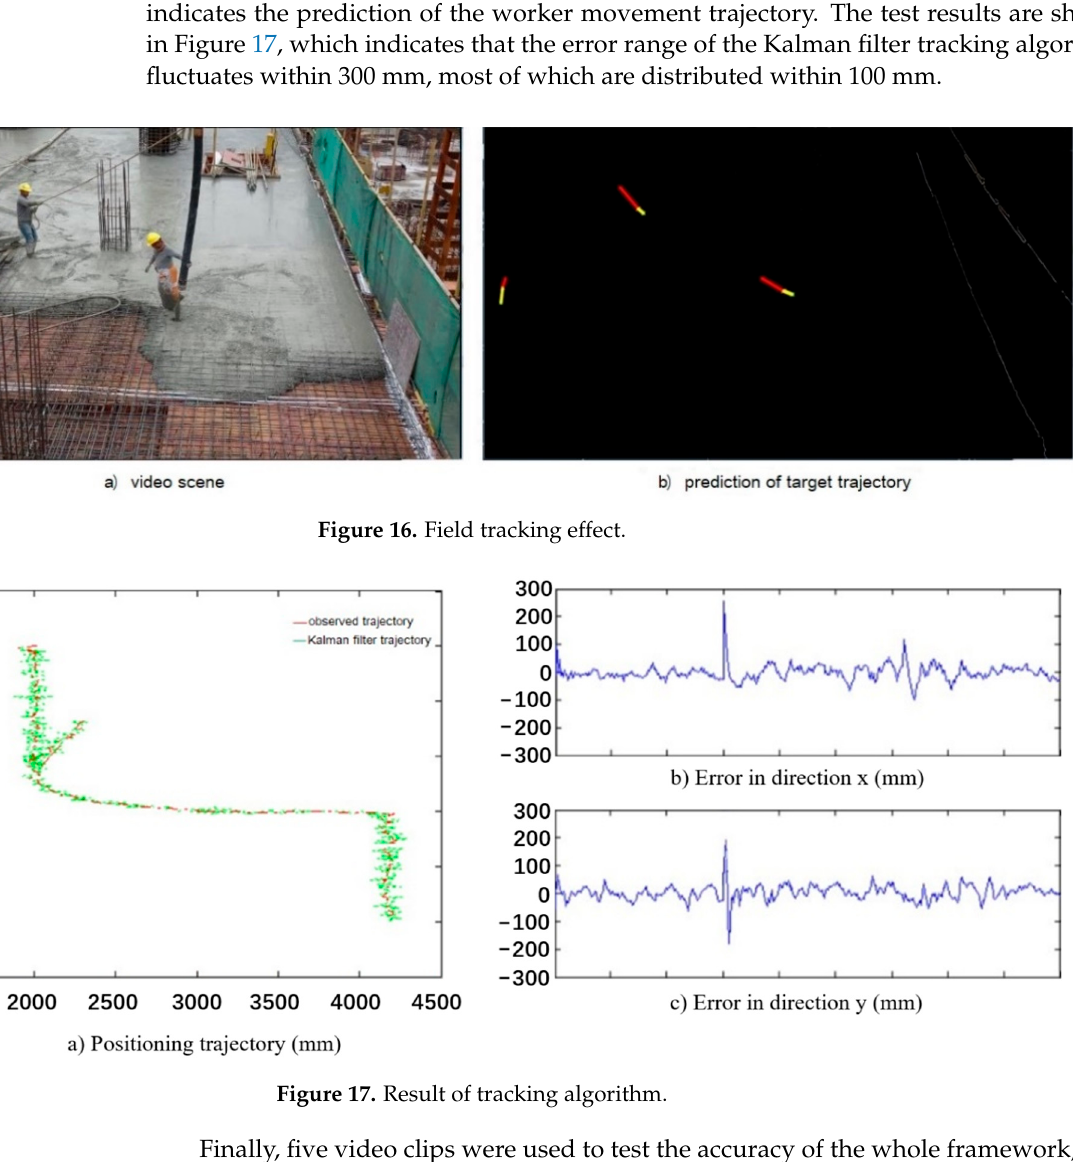
Table 2. Mean error of worker’s safety status monitoring.